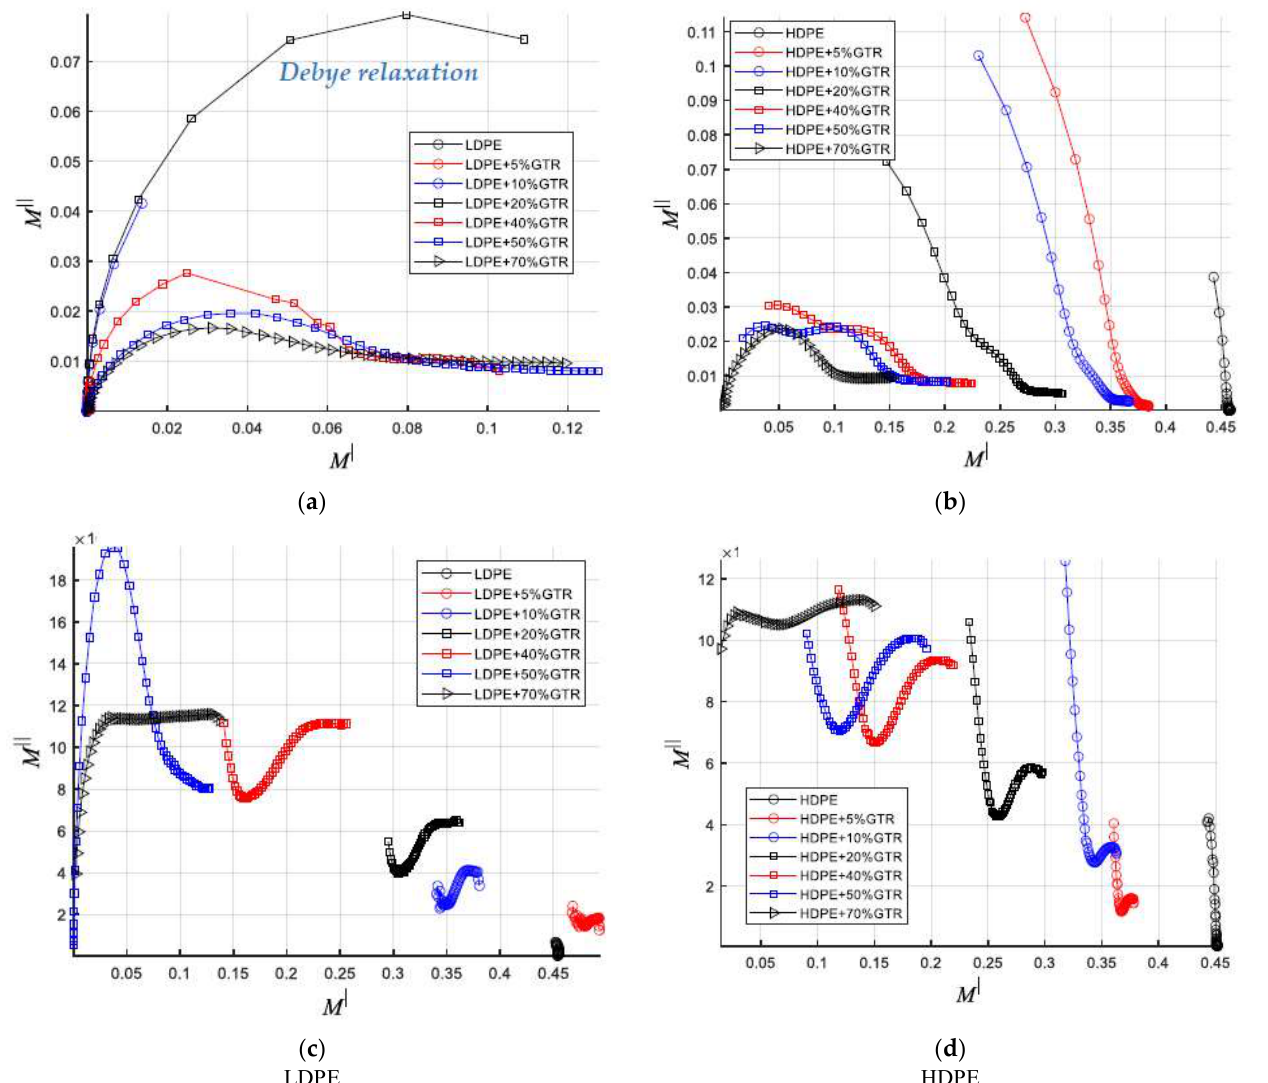
Figure 11. Argand diagram: comparison Figure M”-M’ of ( a ) LDPE/GTR at 120 °C, ( b ) HDPE/GTR at 120 °C, ( c) LDPE/GTR at 30 °C, and ( d ) HDPE/GTR at 30 °C.